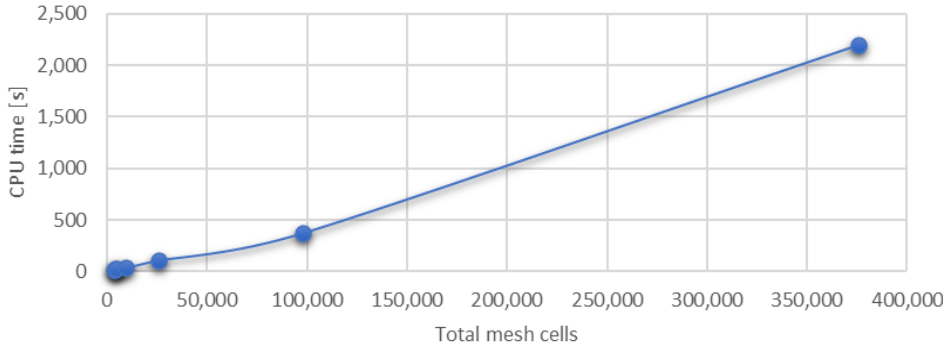
Figure 9. Time of central processing unit (CPU) versus total number of mesh cells for the geometry with lateral air inlet and outlet.